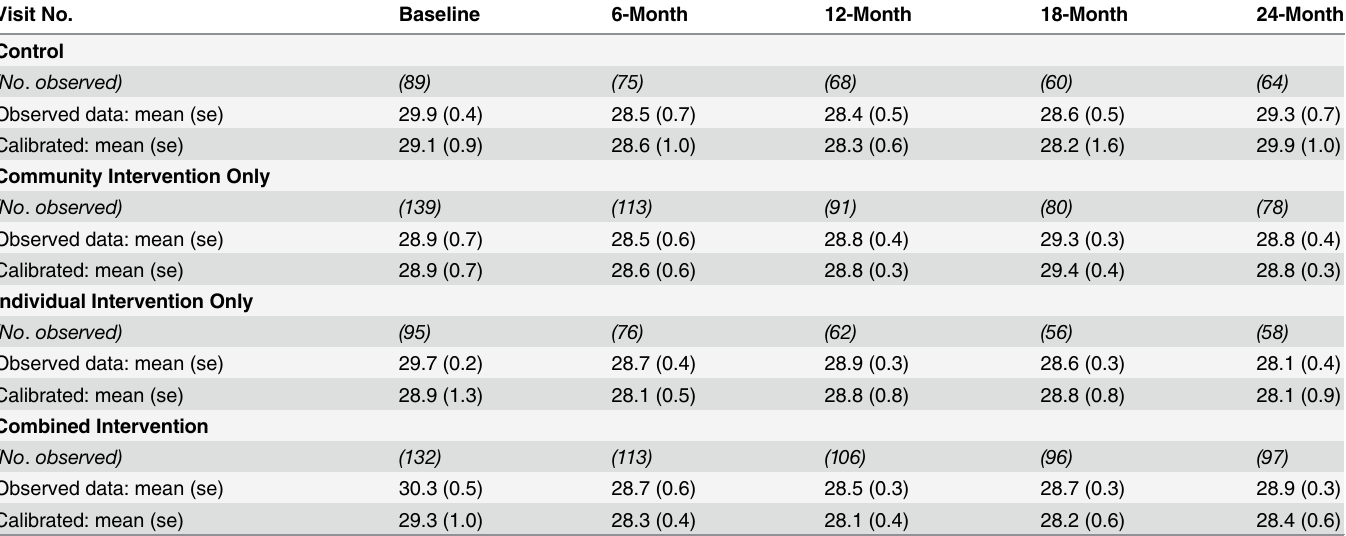
Table 5. Mean and standard error (se) of HIV stigma score among index participants. Visit No.